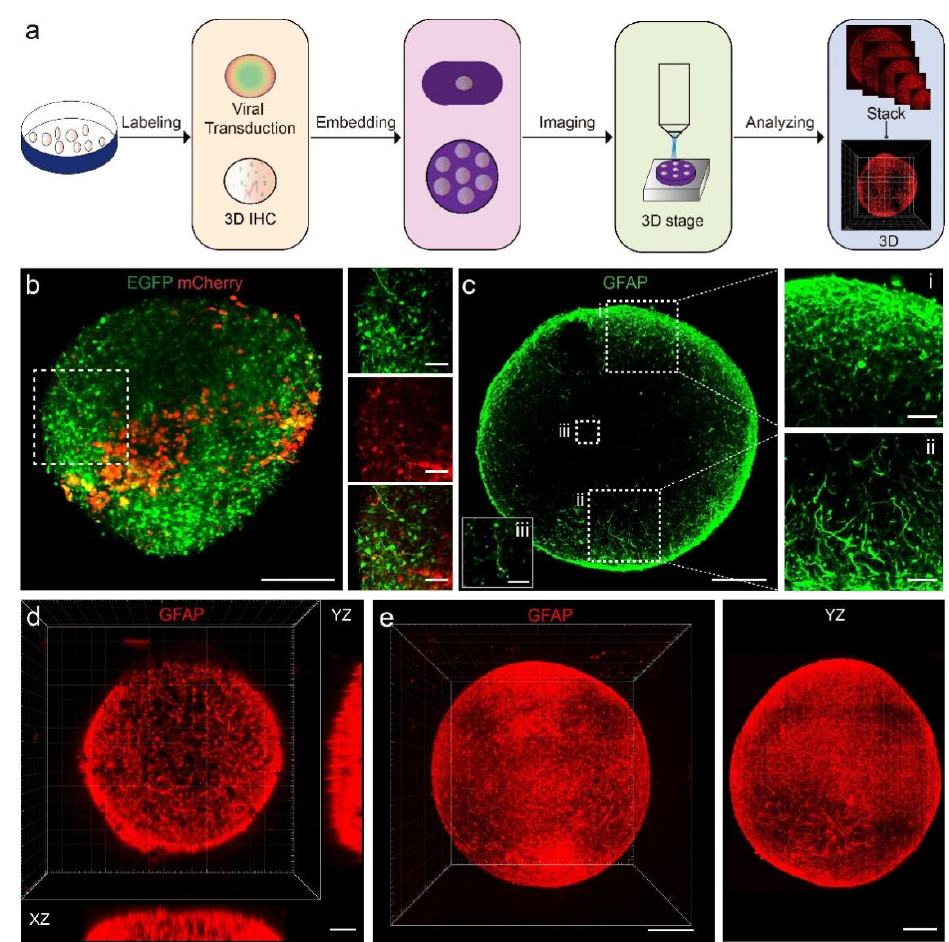
Figure 1. Pipeline for 3D imaging of cerebral organoids. ( a ) Steps for labeling, embedding, imaging, and analyzing of organoids. ( b ) Maximum intensity z-projections of 100- μ m-thick sections showing expression of EGFP and mCherry in neurons and GFAP + cells after viral transduction. Scale bars: 200 μ m (left) and 50 μ m (right). ( c ) Maximum intensity z-projections of 100- μ m-thick sections showing GFAP + cell after 3D immunostaining. Scale bars: 200 μ m ( c ); 50 μ m ( i , ii ); 25 μ m ( iii ). ( d , e ) 3D view of GFAP + cell in an organoid. ( d ) was obtained by confocal microscopy, ( e ) was obtained by fMOST. Scale bar: 200 μ m.